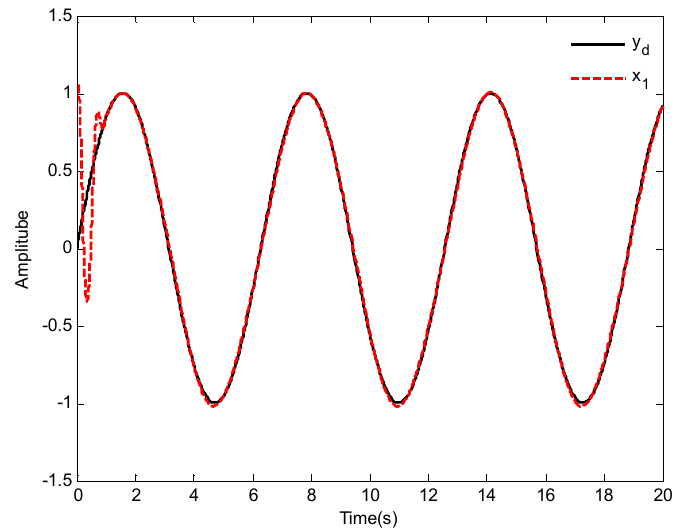
Figure 2. The curves of tracking performance.